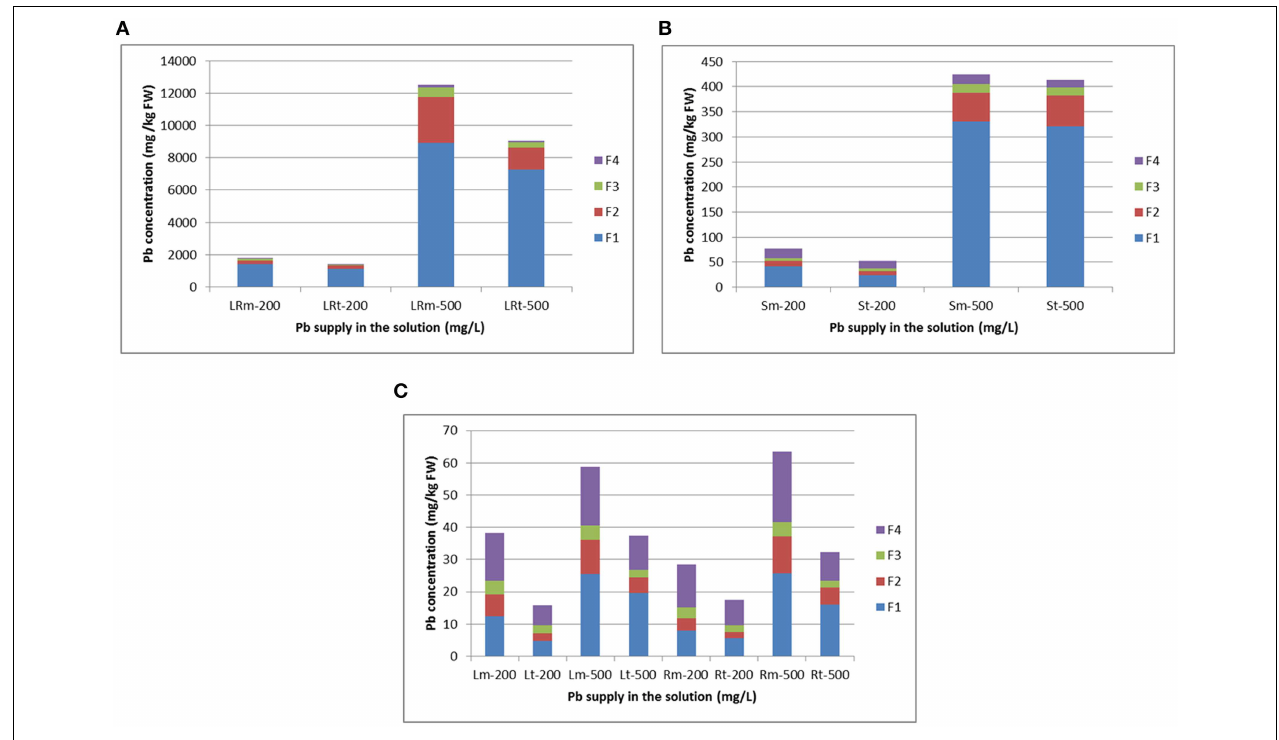
FIGURE 4 | Subcellular distribution of Pb and its stacking proportion in lateral roots (A), root skin (B), and leaves and roots (C) of radish. LRm-200 and LRt-200 as well as LRm-500 and LRt-500 represent lateral root treated with 200 and 500 mg/L Pb(NO 3 ) 2 , respectively; Sm-200 and St-200 as well as Sm-500 and St-500 represent root skin treated with 200 and 500mg/L Pb(NO 3 ) 2 , respectively. Lm-200 and Lt-200 as well as Rm-200 and Rt-200 represent leave and